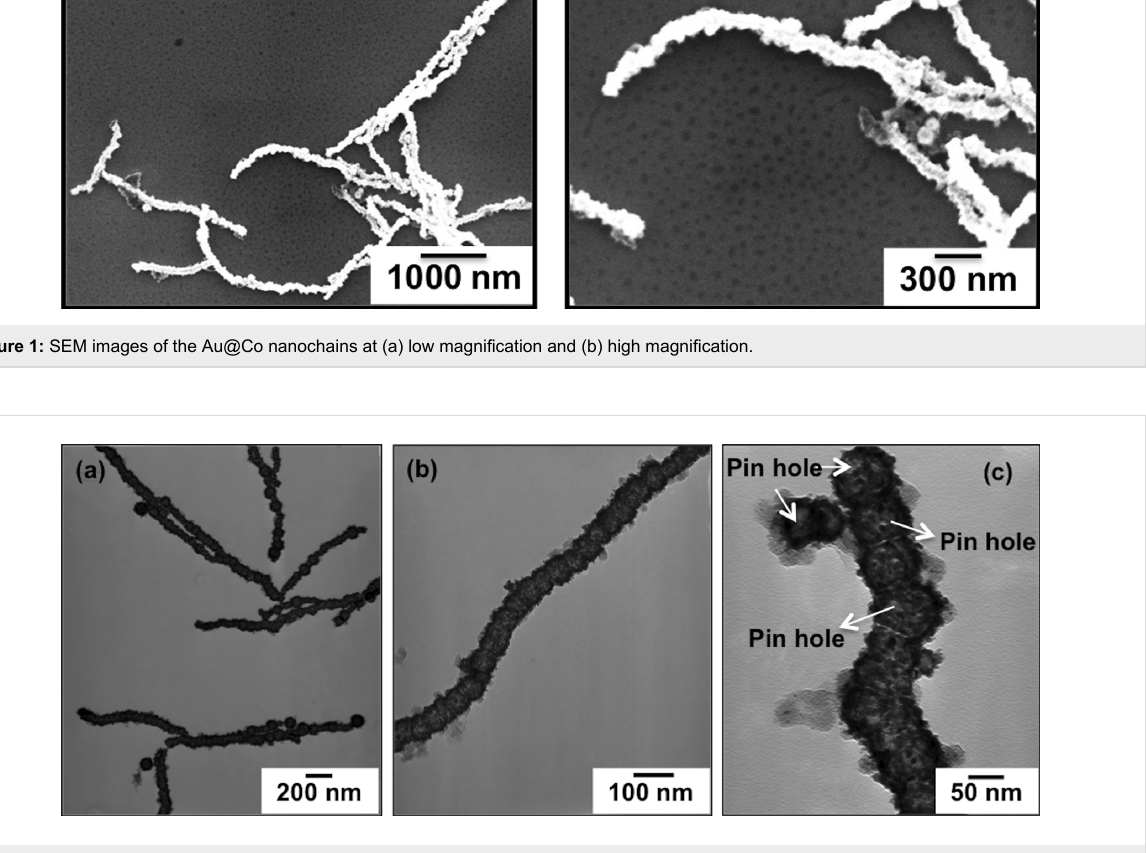
Figure 2: TEM images of the Au@Co nanochains: (a,b) low-magnification and (c) high